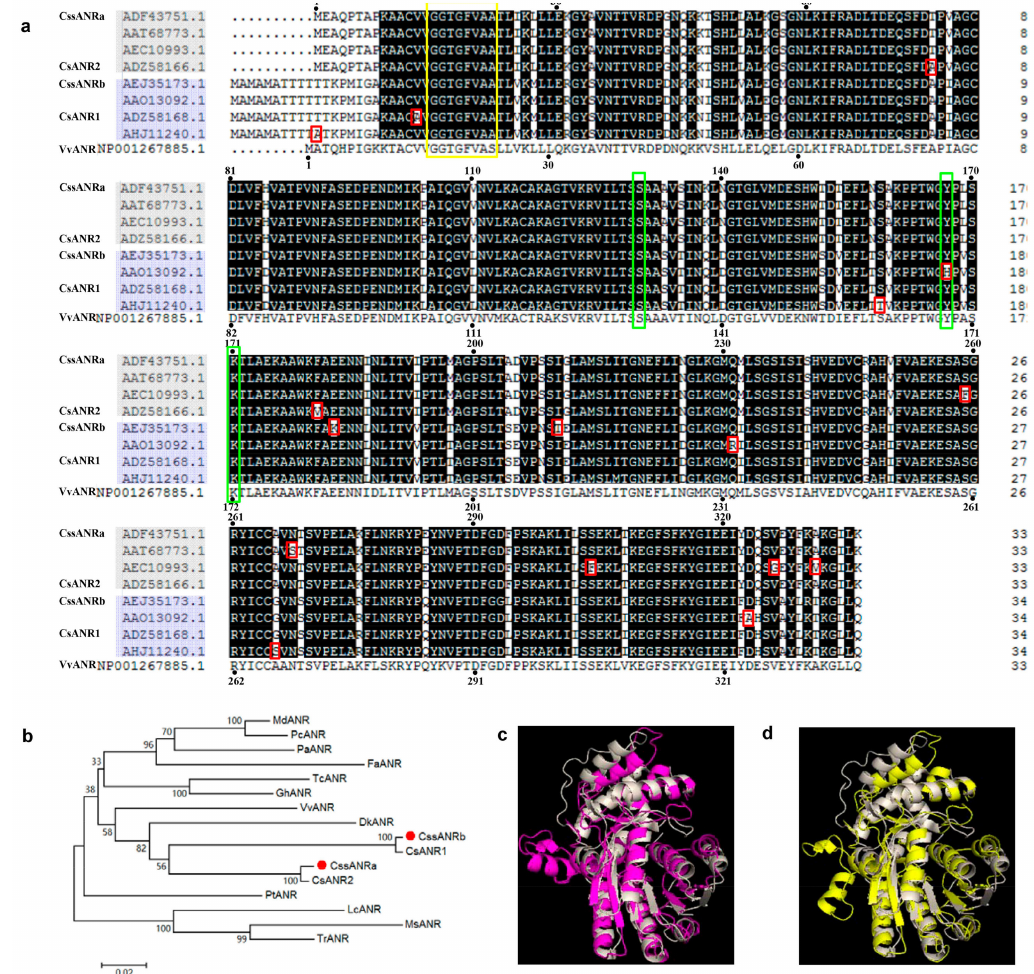
Figure 4. Molecular characterization of two ANR homologs. ( a ) A sequence alignment shows both difference and identity of amino acids in nine homologs. Those different amino acids are highlighted using a small red rectangle. The yellow frame shows G-rich NADPH and NADH binding domain; ( b ) a phylogenetic tree established using 16 ANR homolog amino acid sequences; ( c , d ) Three dimensional structure prediction for CssANRa ( c ) and CssANRb ( d ) using grape ANR template (2rh8A), gray: 2rh8A, red: CssANRa and yellow: